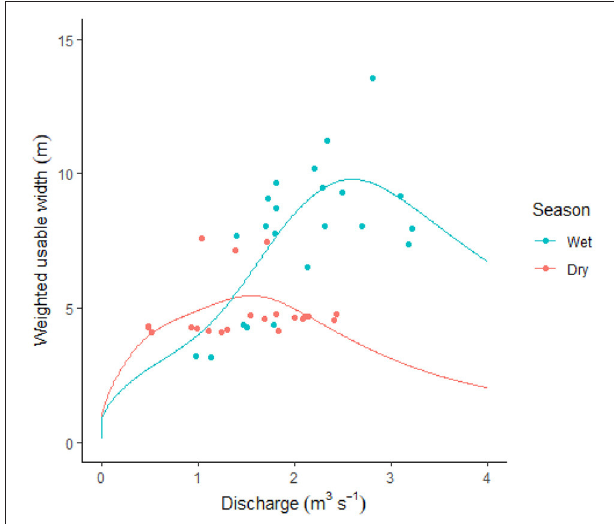
FIGURE 3 | Relationship between weighted usable width (WUW) and flow discharge for Baetis in the Xiangxi River Basin.